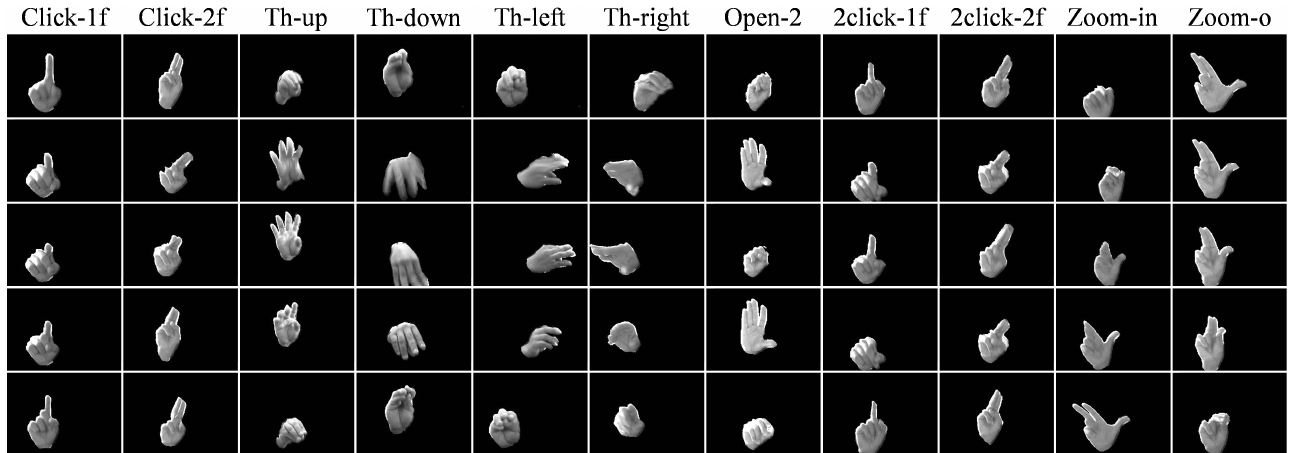
Figure 5. Examples of the 11 action gestures included in the IPN Hand dataset. The temporal order is shown from top to down rows. For visualization purposes, segmented hand masks were blended to the RGB images. Note that not shown here are the pointing and the non-gesture